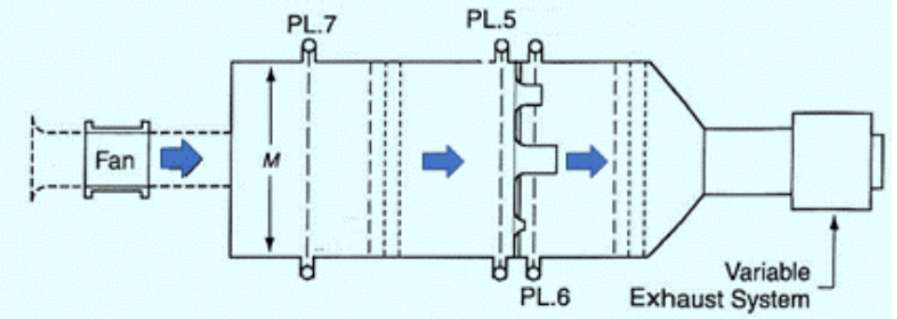
Figure 4. Wind tunnel structure diagram.